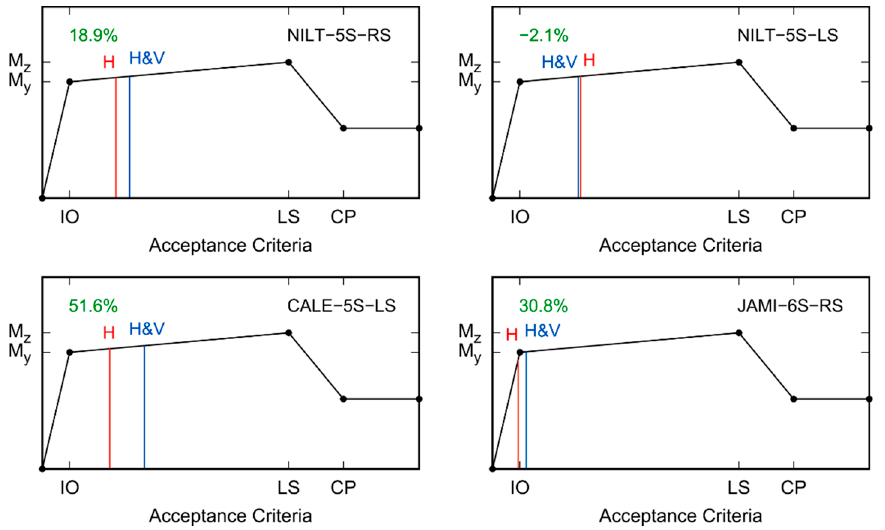
Figure 15. Examples of acceptance criteria for the 6-story building. Part 1.